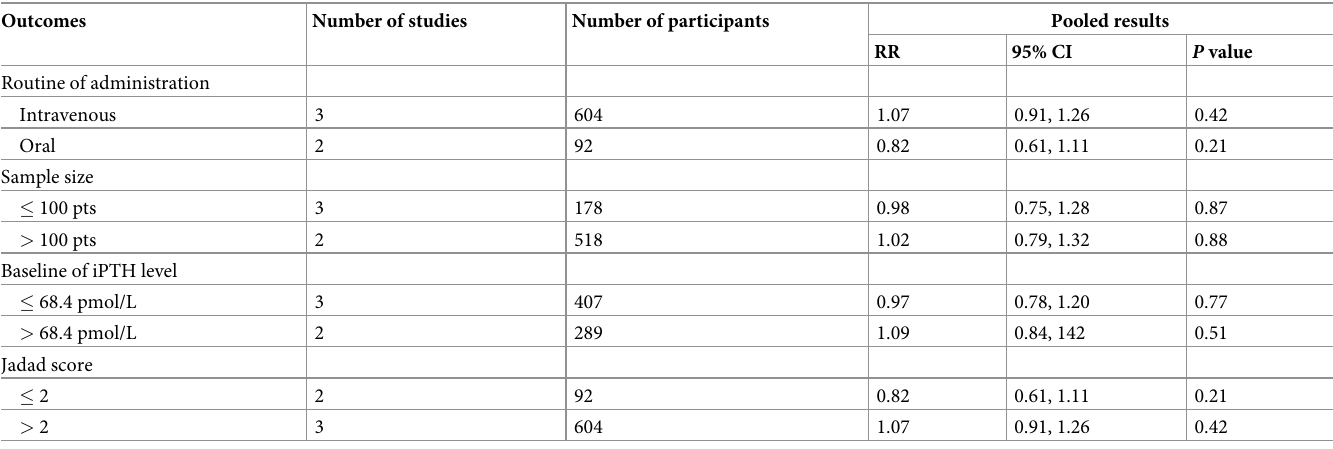
Table 3. Subgroup analysis of the comparison of paricalcitol versus VDRA regarding reduction of iPTH from baseline.